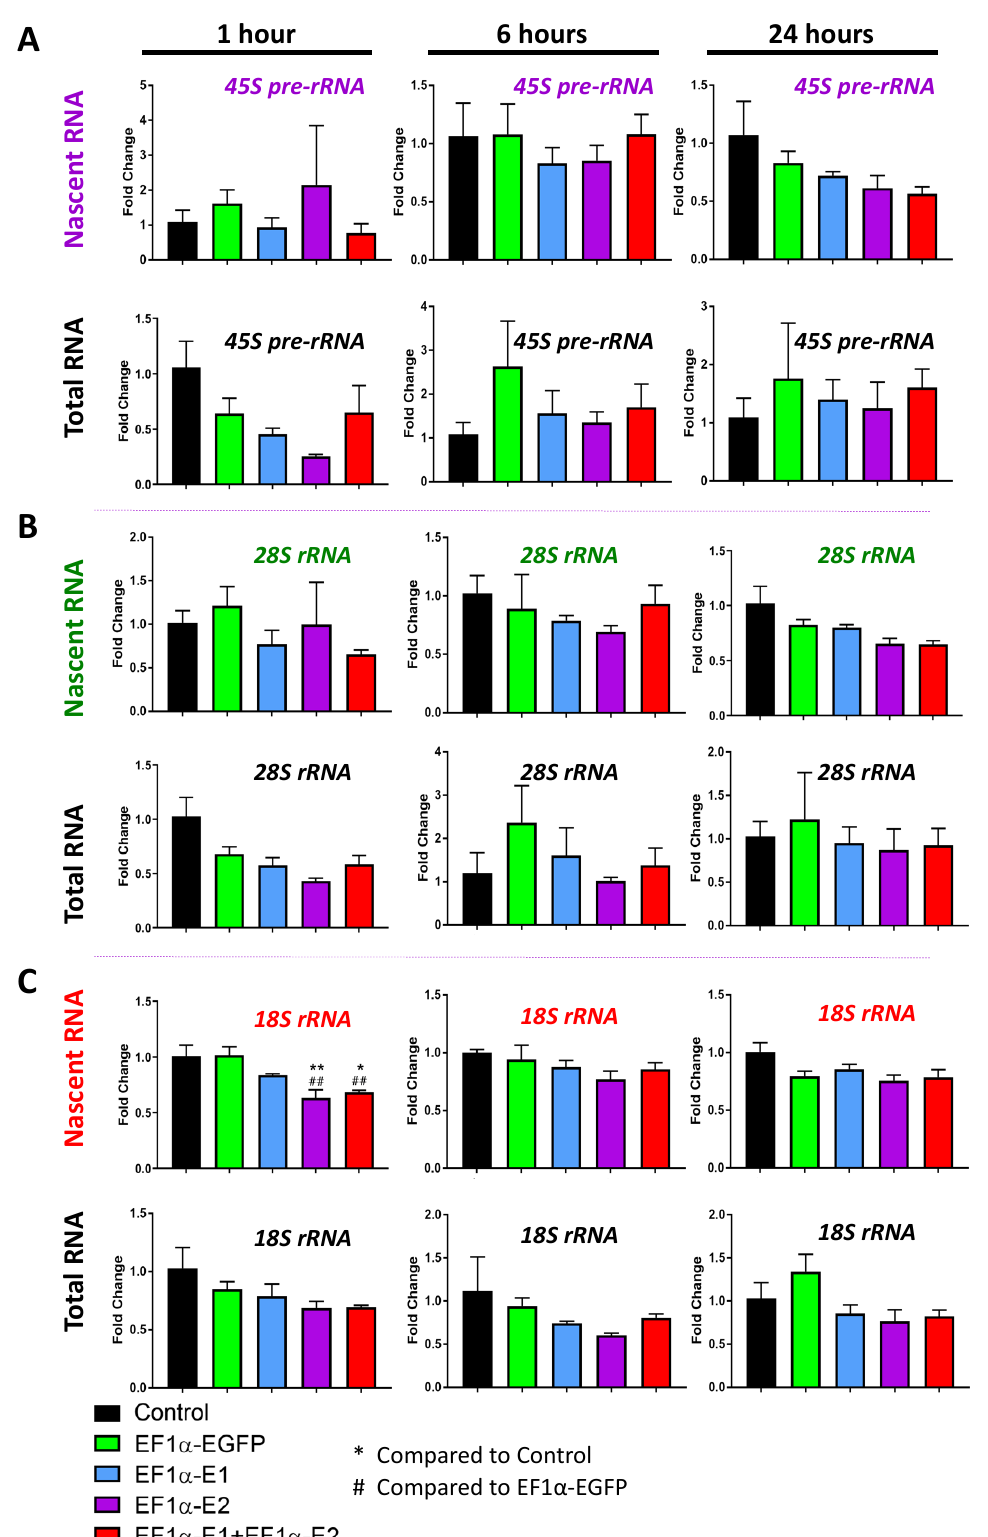
Figure 8. Expression of the nascent and steady-state 45S pre-rRNA and 28S and 18S rRNA transcripts in Daoy cells transduced with lentiviral vectors expressing MeCP2 isoforms. Nascent RNA was prepared from cells labelled with EU for 1 h, 6 h, and 24 h. Total RNA was prepared from unlabeled cells collected at the same time points. Gene expression was analyzed by RT-PCR for ( A ) 45S pre- rRNA transcripts, ( B ) 28S rRNA transcripts, and ( C ) 18S rRNA transcripts. C T values were normal- ized to the housekeeping gene GAPDH, and fold change was determined relative to average non- transduced control cells. n = 3, and data are reported as mean ± SEM. Fold change values were ana- lyzed by two-way ANOVA followed by Tukey’s multiple comparisons test: *: p < 0.05 and **: p < 0.01 (* indicates the difference from control; # indicates the difference from EF1 α -EGFP, respectively).